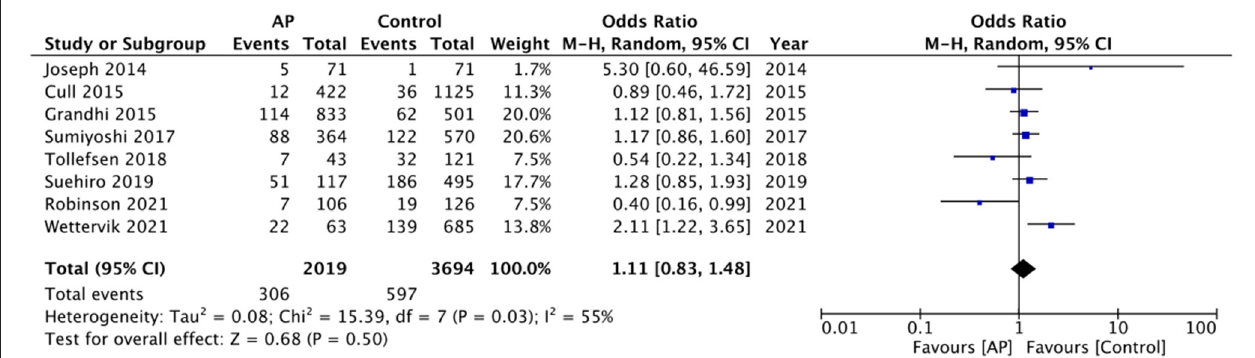
FIGURE 5 | Meta-analysis of need for surgical intervention between antiplatelet users vs. controls.